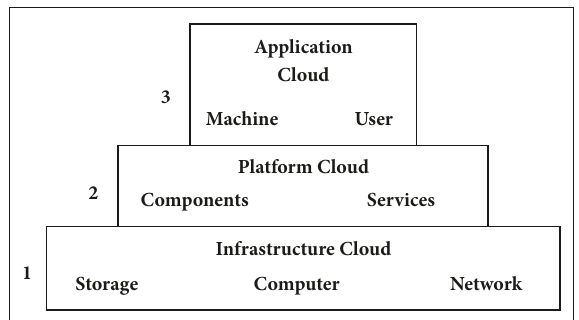
Figure 1: Cloud computing